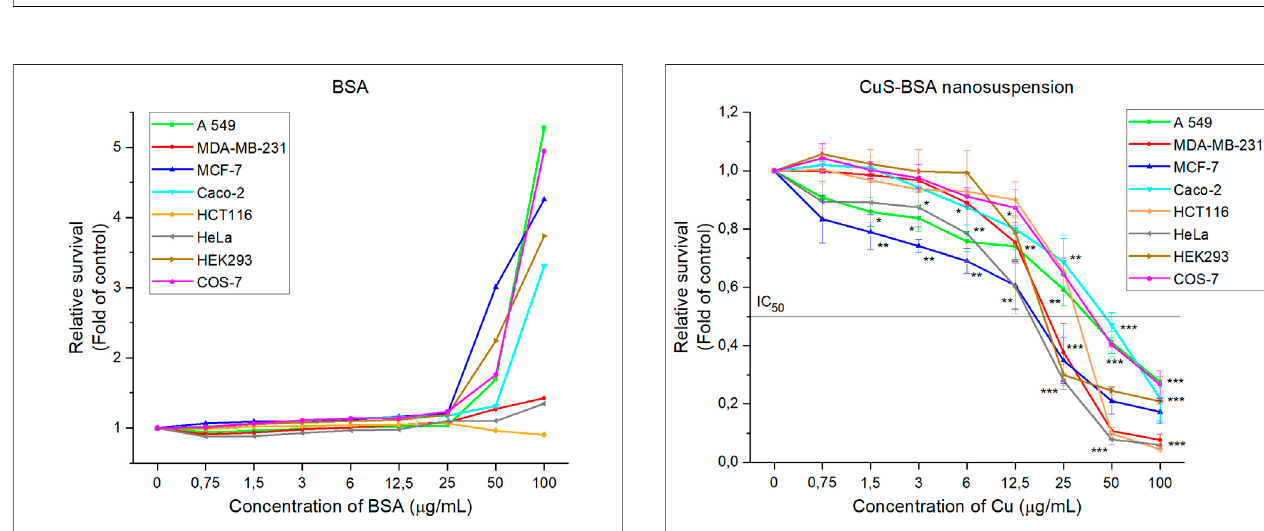
above 3 μ g/ml for the COS-7 cell line and above 6 μ g/ml for the HEK293 cell line. The most sensitive cells tested appear to be HeLa